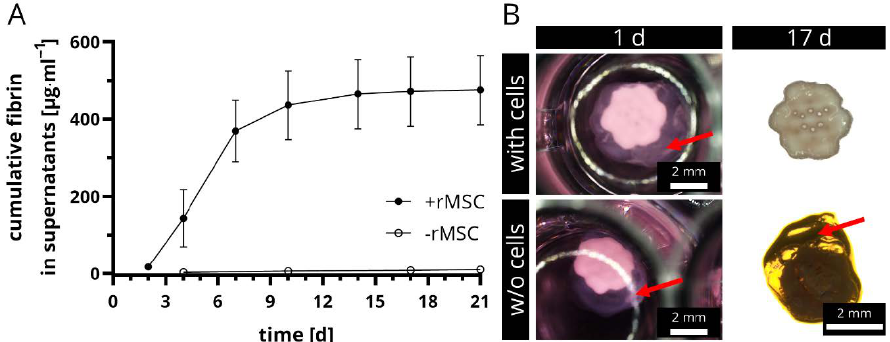
Figure 3. Degradation of fibrin in presence of CPC scaffolds. The concentration of fibrin degradation products in supernatants of rMSC-laden and rMSC-free biphasic CPC-fibrin constructs was measured over time, a cumulative release curve is shown ( A ) (mean ± SD, n = 5). Stereomicroscopical images clearly revealed that fibrin was only degraded in presence of rMSC, whereas cell-free scaffolds showed no signs of degradation ( B ). Red arrows tag the fibrin gel. Scale bars represent 2 mm.